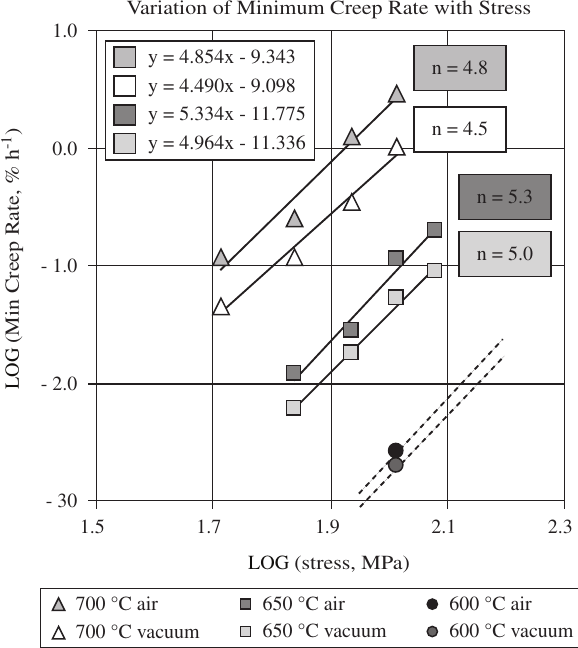
Figure 7. Variation of minimum creep rate with stress for 2.25Cr-1Mo steel, in air and vacuum.